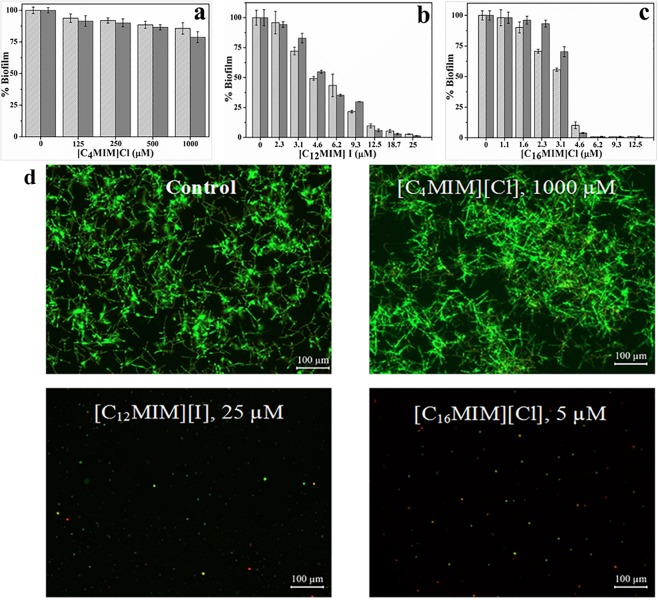
Biofilm formation by C. albicans 10231 at different initial concentrations of [C4MIM][Cl] (a), [C12MIM][I] (b), and [C16MIM][Cl] (c). Biofilm quantified by CV (light gray) and XTT (dark gray) was presented. Fluorescence microscopic images of C. albicans biofilms in presence of different concentrations of ionic liquids (d).